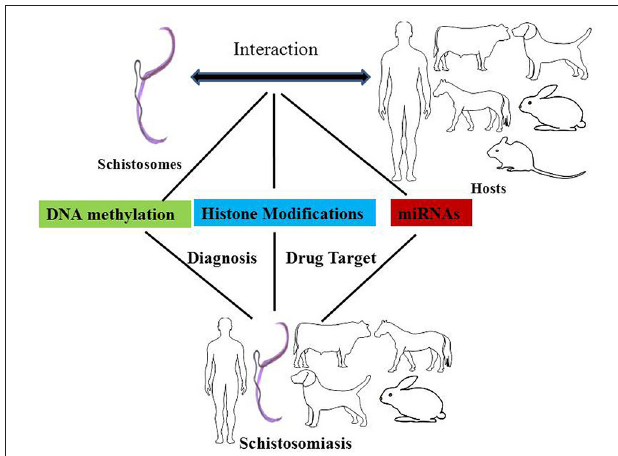
FIGURE 1 | The effects of epigenetic modifications on the interaction between schistosomes and hosts, drug targets against schistosomiasis, and biomarkers for the diagnosis of schistosomiasis. DNA methylation, histone modifications, and miRNAs play important roles in epigenetic modifications in the interaction between schistosomes and hosts. DNA methyltransferases, histone acetyltransferases (HATs), and histone deacetylase are potential drug targets against schistosomiasis. In addition, the levels of DNA methylation and miRNAs can be used as diagnostic biomarkers for